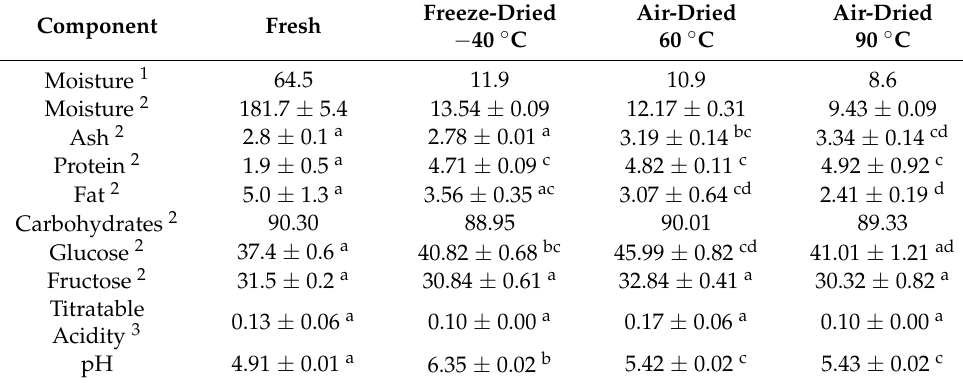
Table 1. Chemical composition of wild blueberry ( Sideroxylon mascatense ) flesh. Component